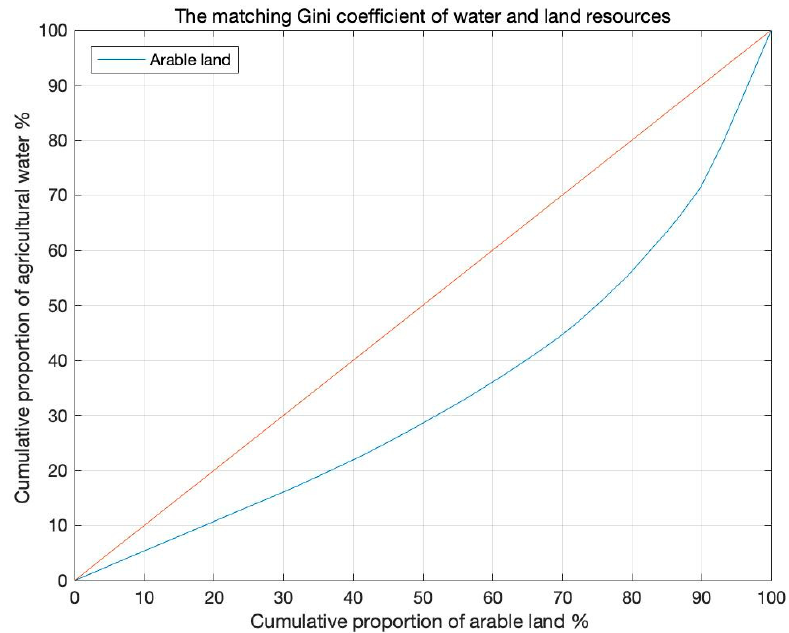
Figure 5. Lorentz Curve of Water and Land Resources Matching in Chengdu–Chongqing Economic Circle in 2018.